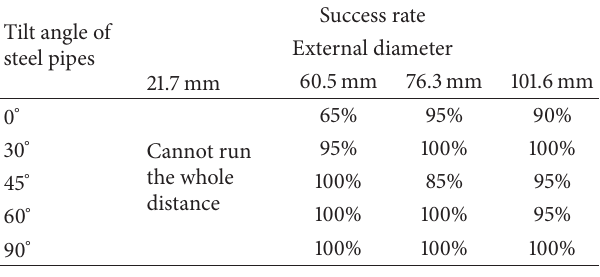
Table 3: Success rate for movement on the pipe. Tilt angle of